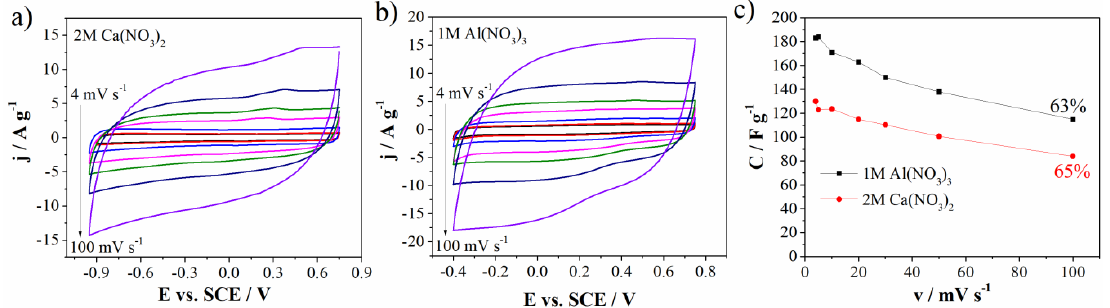
Figure 7. CVs of Mn 3 O 4 @N-doped carbon electrode in ( a ) 2M Ca(NO 3 ) 2 , ( b ) 1M Al(NO 3 ) 3 , and ( c ) specific capacitance values versus scan rate with capacitance retention.